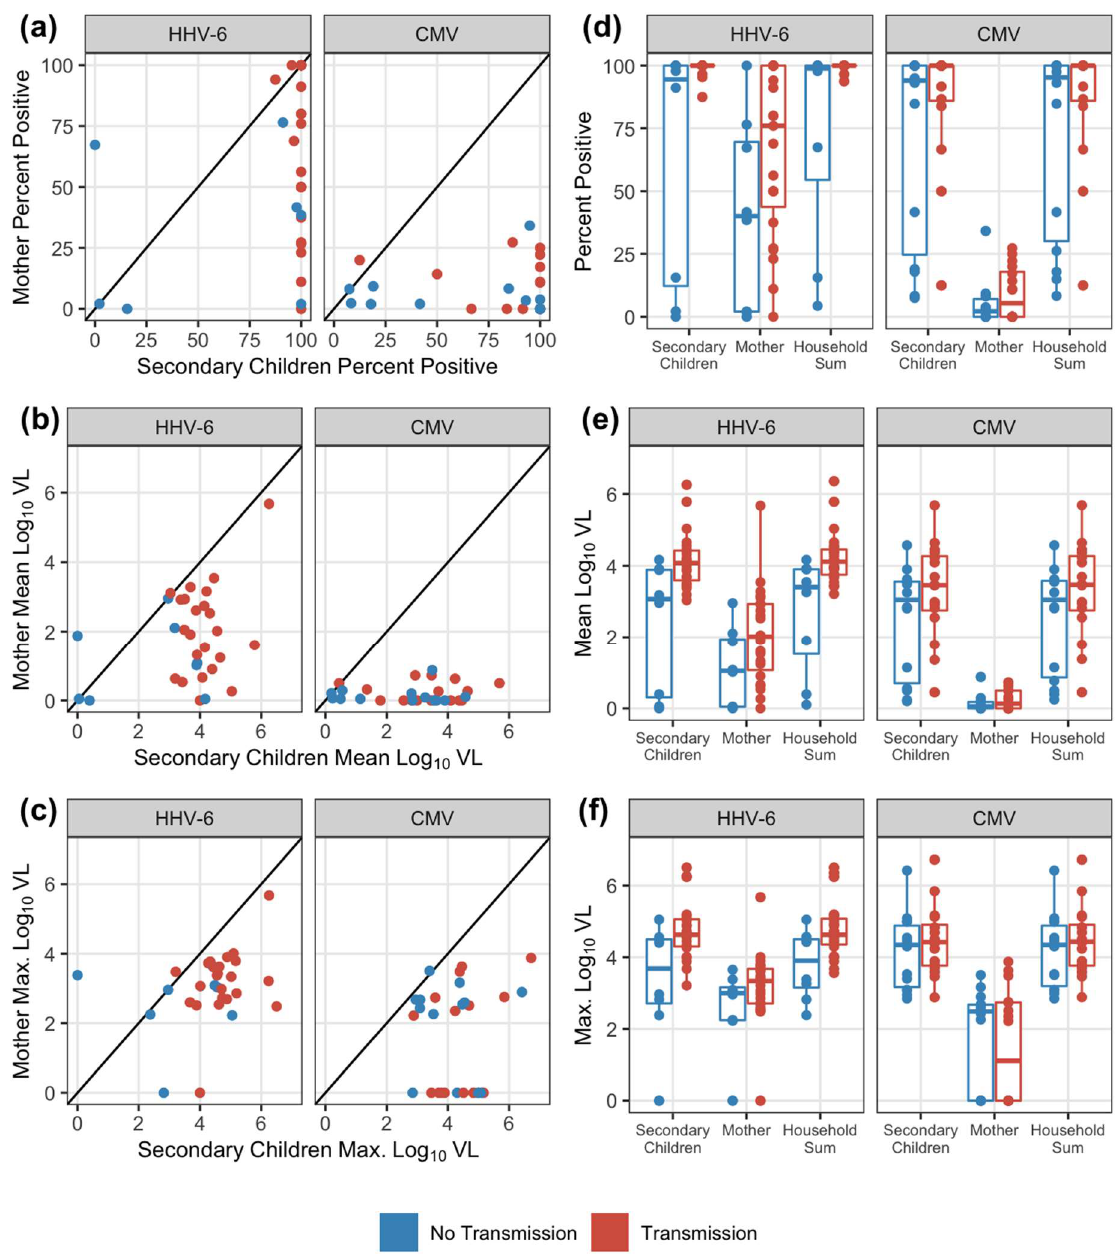
Figure 2. Comparisons of exposure patterns across households and among household members. Comparing viral exposure patterns for HHV-6 and CMV between mother and secondary children within a household by ( a ) percent positive weekly swab measurements; ( b ) mean log viral load (VL; DNA copies / mL); and ( c ) maximum log viral load. The diagonal line in the scatterplot denotes equivalent summary measures between household mother and secondary children (i.e., the points below the line indicate lower measurements from the household mother). Shedding patterns by exposure source compared between households without and with transmission by ( d ) the percent of positive weekly measurements; ( e ) the mean log viral load; and ( f ) the maximum log viral load. Boxes represent the interquartile range, stems represent values within 1.5 of the IQR, and points represent the raw data. All observed exposures measured in the infant’s first year of life and prior to transmission times are shown. Table 1. Estimates of the weekly risk for each virus with no exposure (constant weekly risk) and by exposure source. Models of risk were fit without exposure (null model) and independently for each exposure source. Weekly risk with exposure includes constant risk from the model. The mean